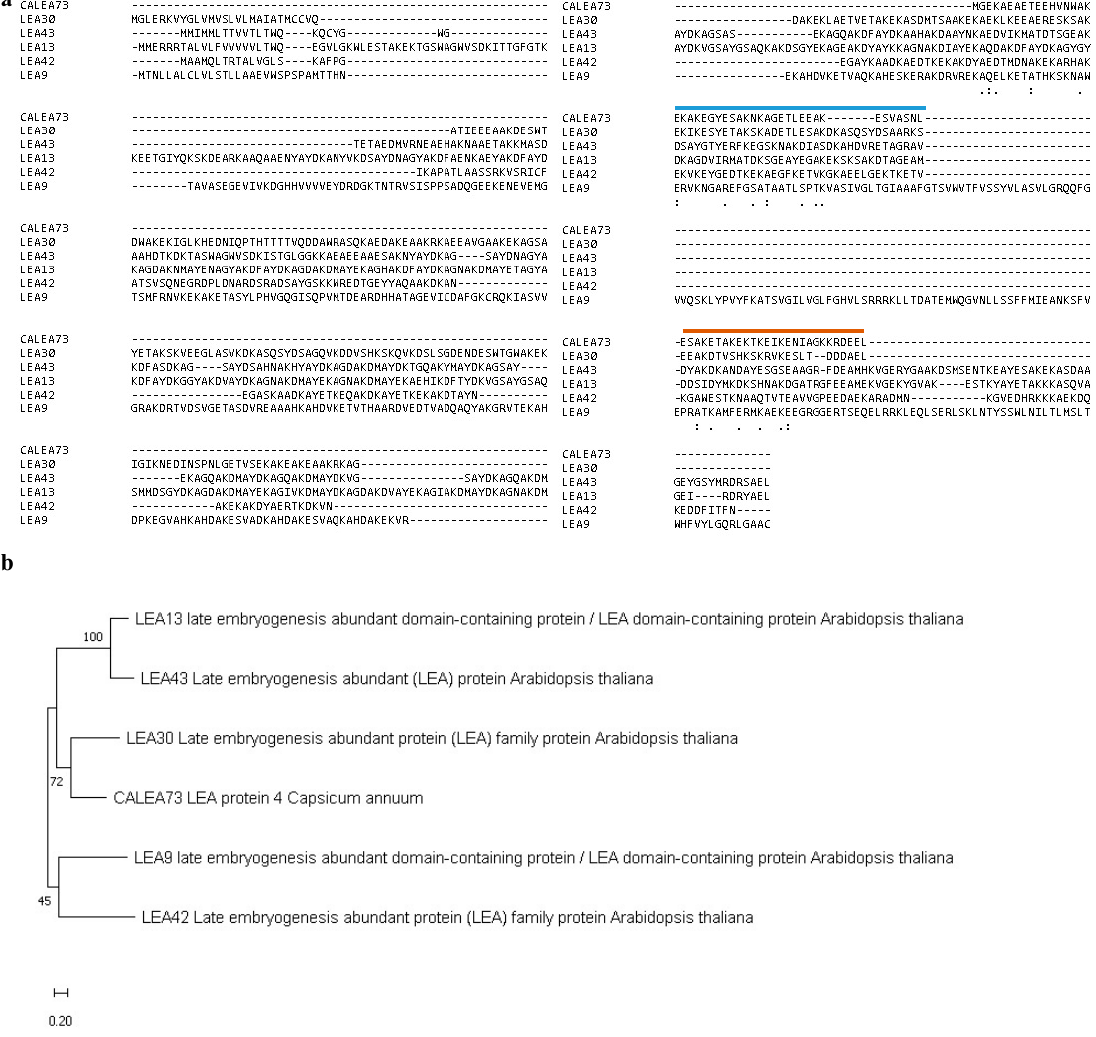
Figure 1. The alignment of the amino acid sequences and phylogenetic relationships between selected proteins and CaLEA73. ( a ) Amino acid sequences alignment of candidate proteins. They were aligned using the ClustalW program; dashed lines were introduced to maximize sequence alignments. The blue line indicates the first conserved region and the orange line second conserved region. ( b ).